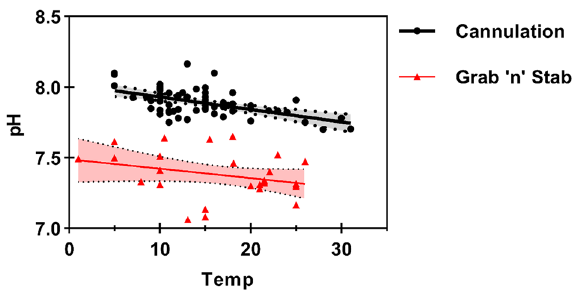
Figure 1. The relationship between blood pH and temperature for a range of fish species. Black filled circles represent data obtained from surgically cannulated fish from 38 species in total (based on the review by Hillman & Hedrick 23 with much of the original data collated by Ultsch & Jackson 24 ). Red triangles represent data collected using the grab n’ stab method from a range of species collated from published papers by the current authors (see Supplementary Material). Solid lines represent regression relationships through the data collected via the two blood sampling methods. The dotted lines around the regression line are the 95% confidence intervals. Linear regression analysis showed that the slopes of the two lines were not significantly different (p = 0.58), but the elevations were significantly different from each other (p < 0.0001), with the average difference between the two methods being 0.53 pH units, which represents a threefold increase in H + ions using grab ‘n’